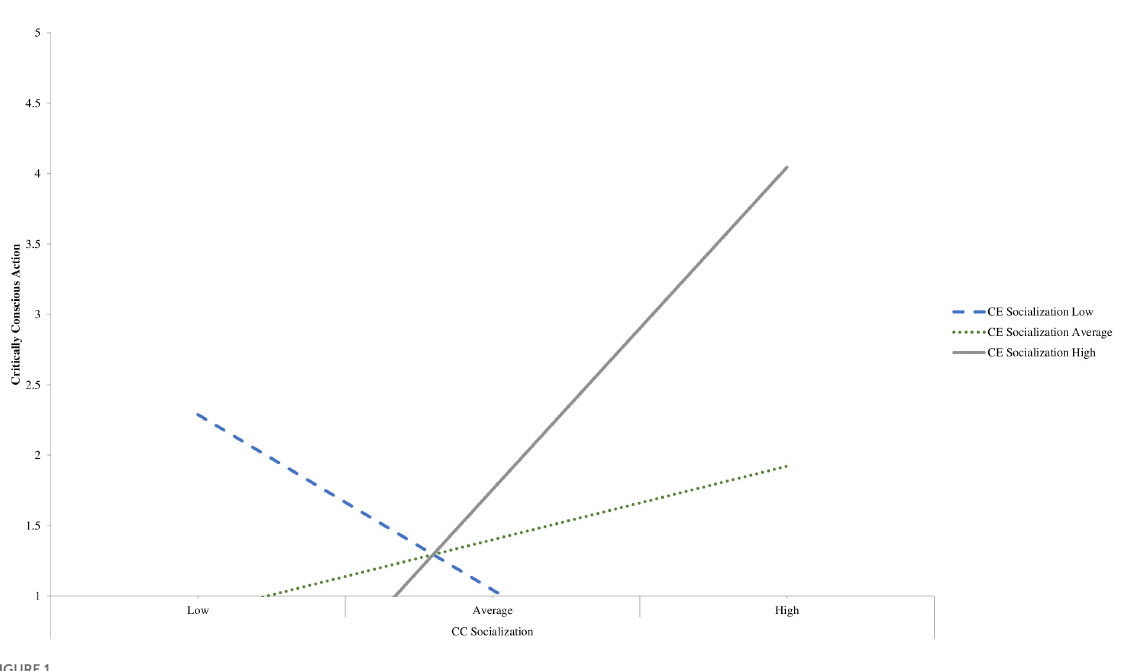
FIGURE1 Graph of simple slopes analysis, critically conscious